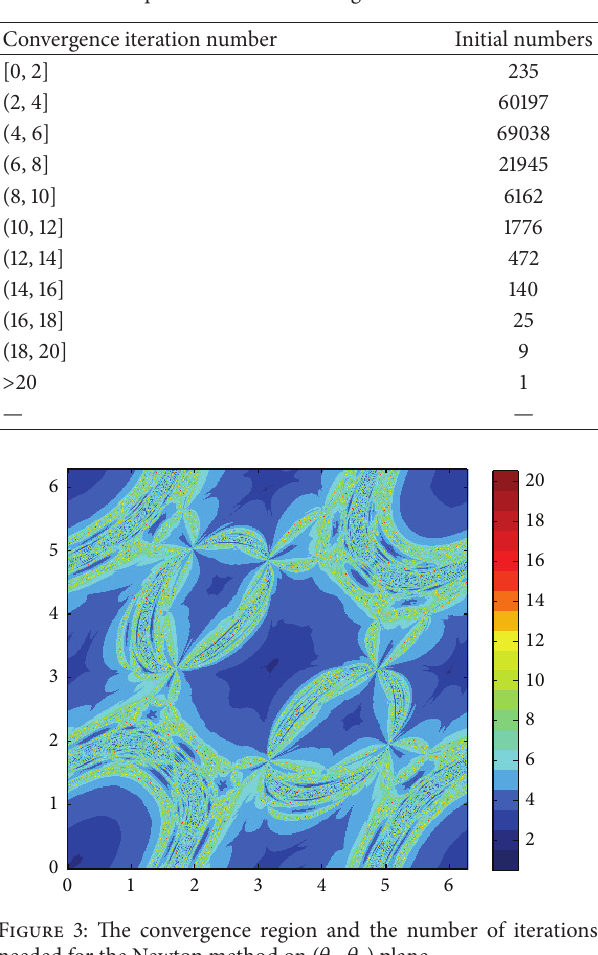
Table 2: Required Iterations starting from different initials.